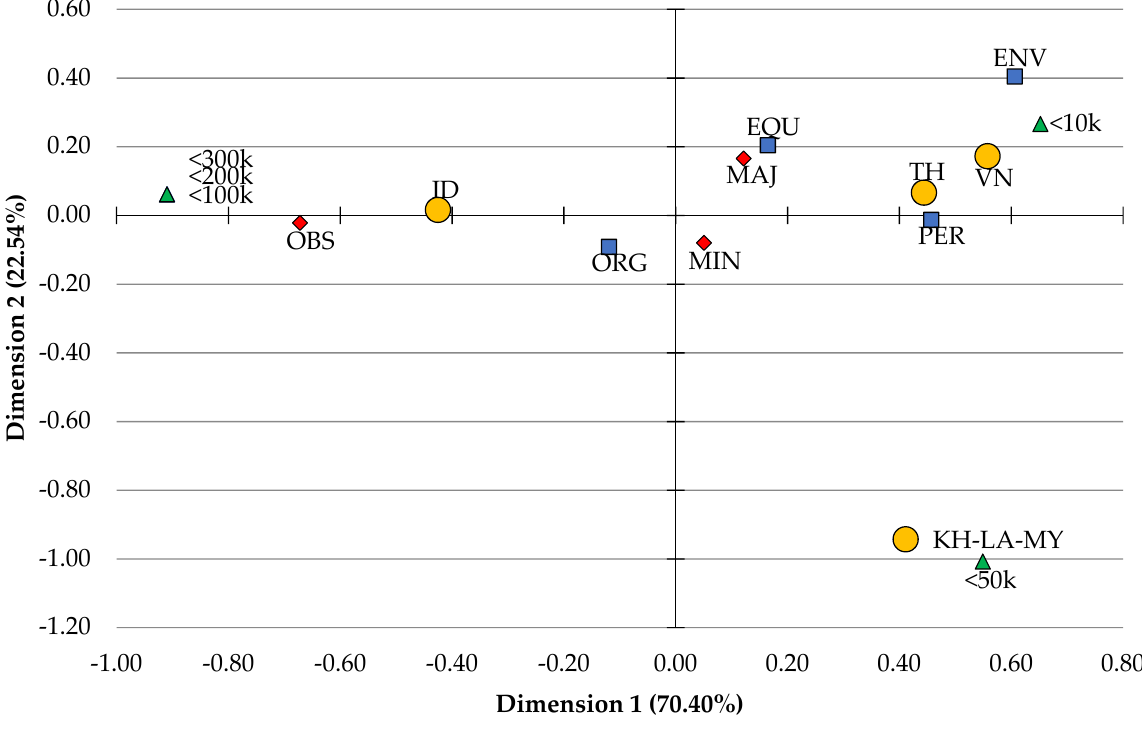
Figure 5. Biplot of Correspondence Analysis based on all factors and country groups.